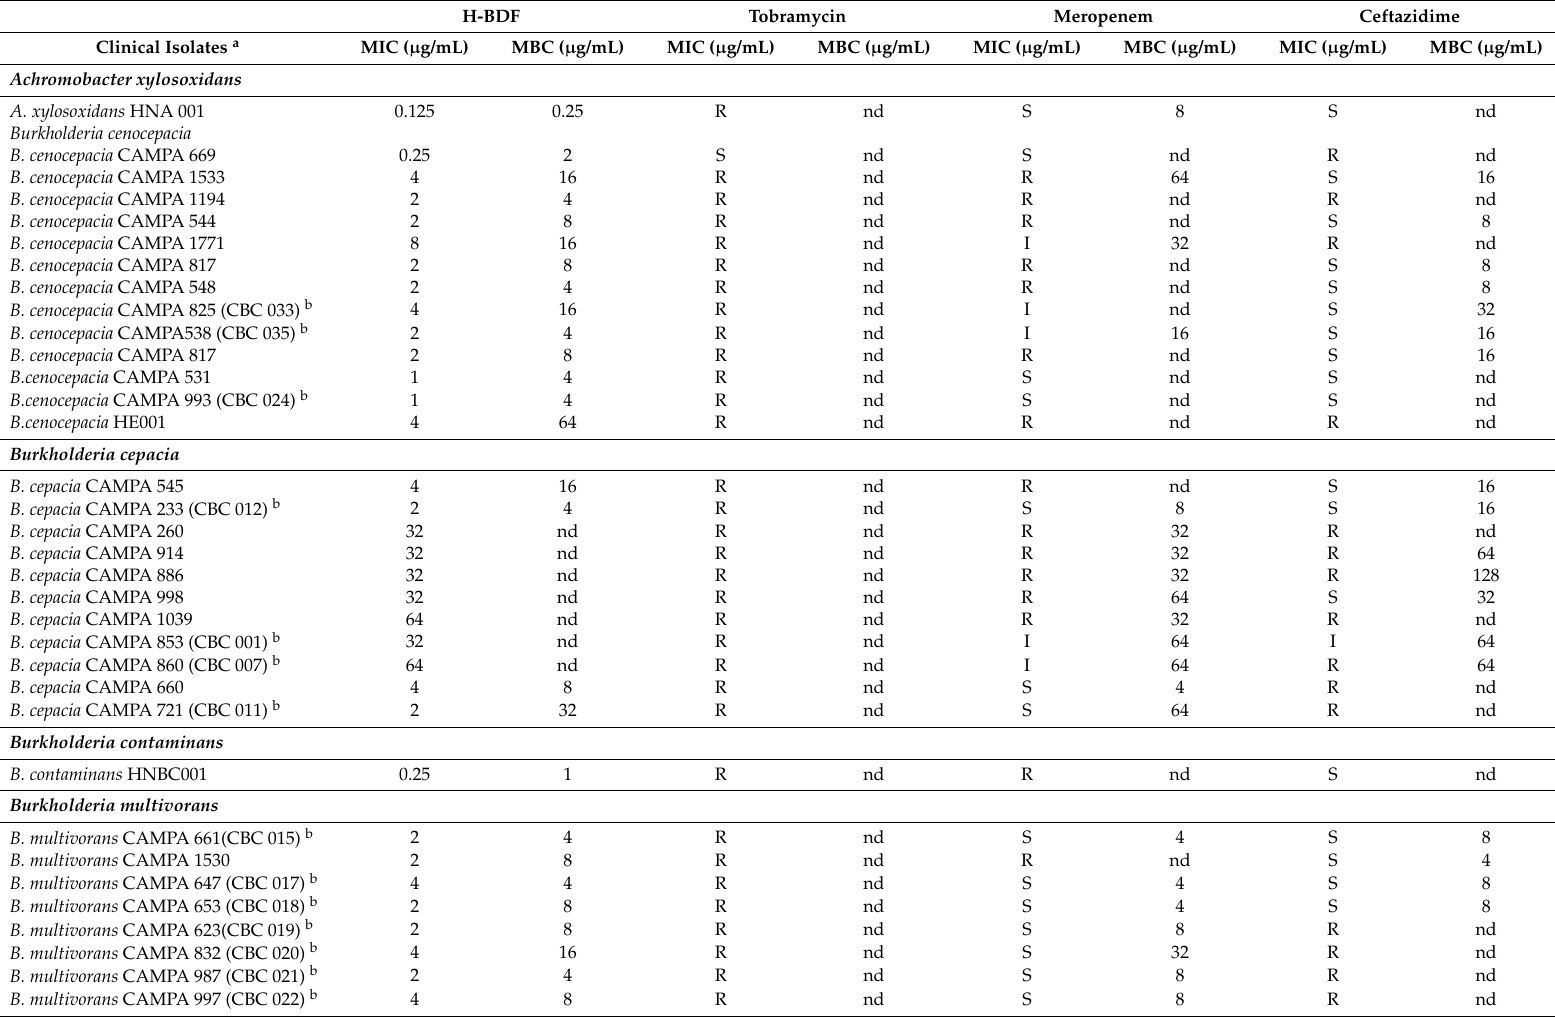
Table 4. Microbial susceptibility of multi-resistant isolates recovered from patients with cystic